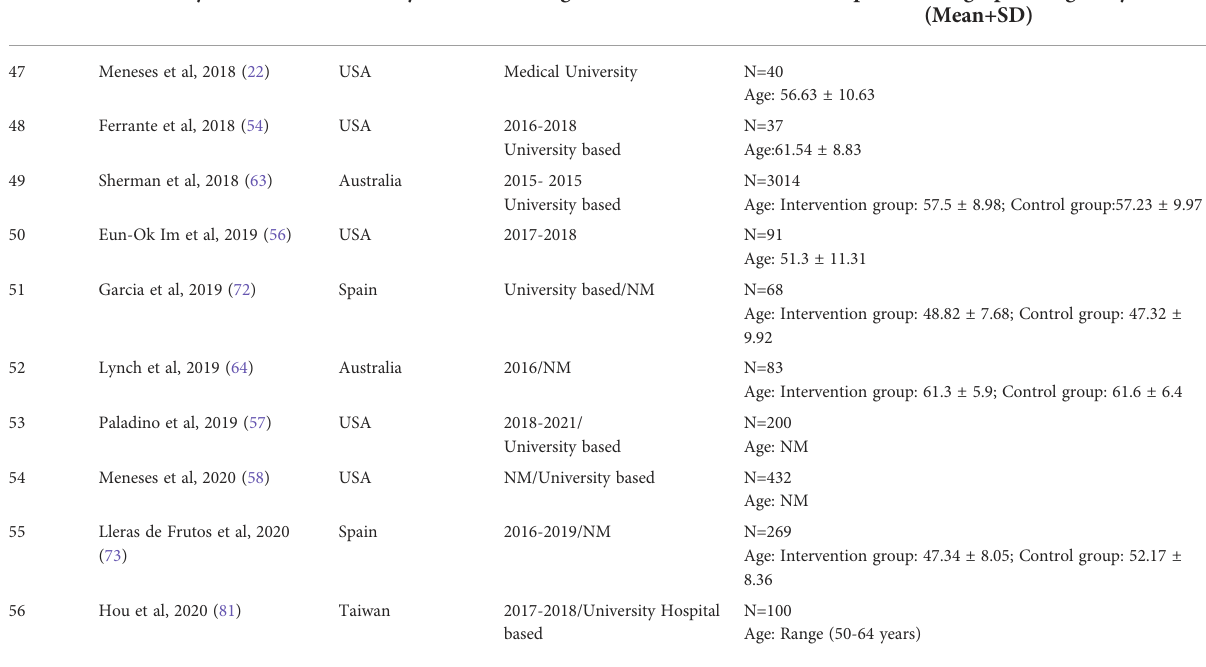
breast cancer patients (SMD 0.48, 95% CI 0.03 to 0.92, p=0.04) (Figure